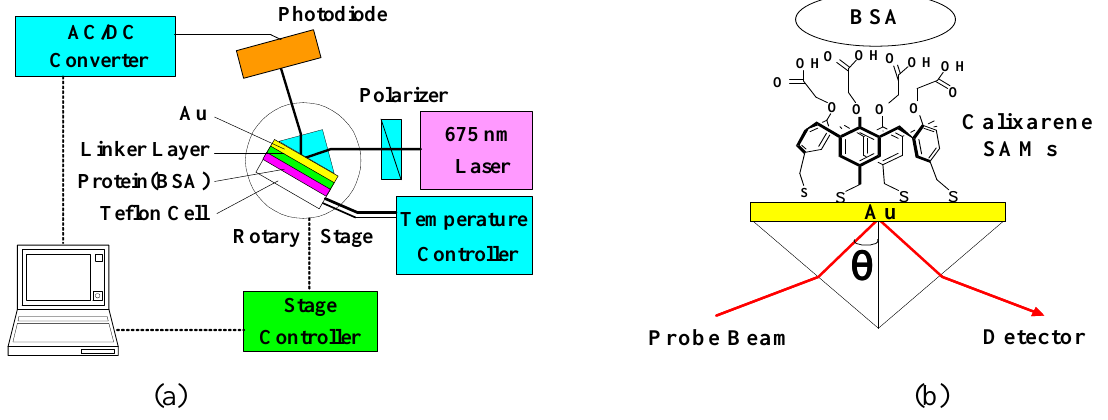
Figure 2 . Schematic diagram of (a) the homemade SPR system and (b) a sensor chip